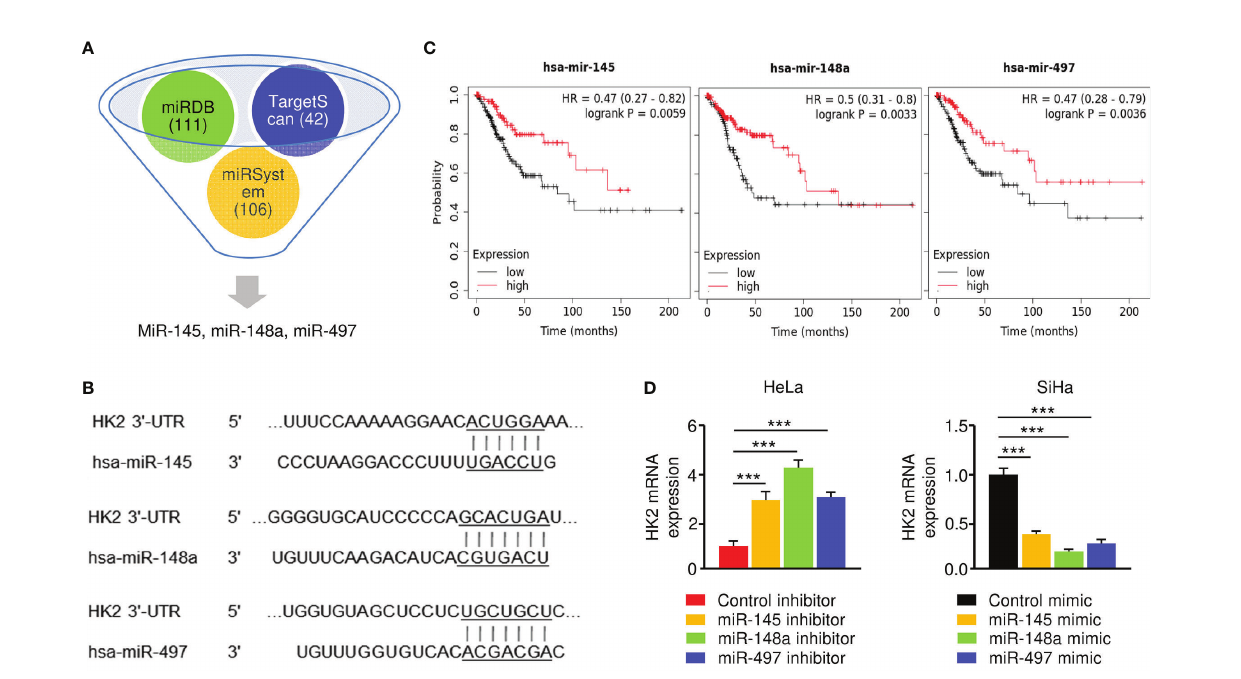
FIGURE 3 | HK2 is negatively regulated by miR-145/148a/497 in CC Cells. (A) Prediction analysis revealed that several miRNAs might regulate HK2 expression. (B) The binding sites of miR-145/148a/497 in the wild-type HK2 3 ′ -UTR were shown. (C) Survival analysis using the KM plotter database was conducted to assess the prognostic value of miR-145/148a/497 in CC patients. (D) The overexpression (or knockdown) of miR-145/148a/497 decreased (or increased) the mRNA expression of HK2 in CC cells. *** P < 0.001.